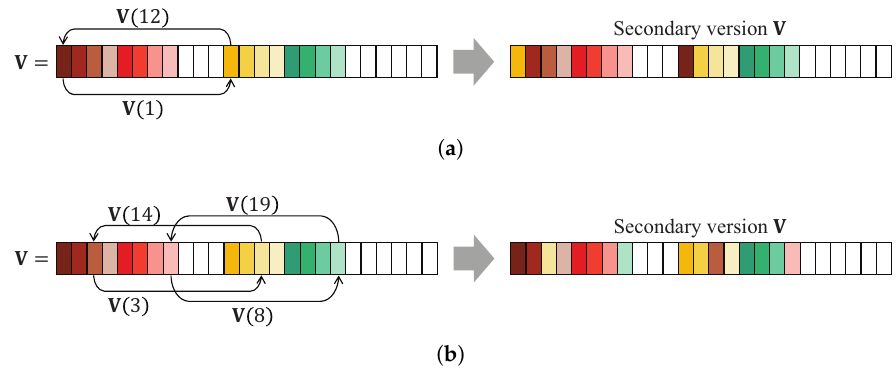
Figure 8. Examples of methods to generate secondary versions V .